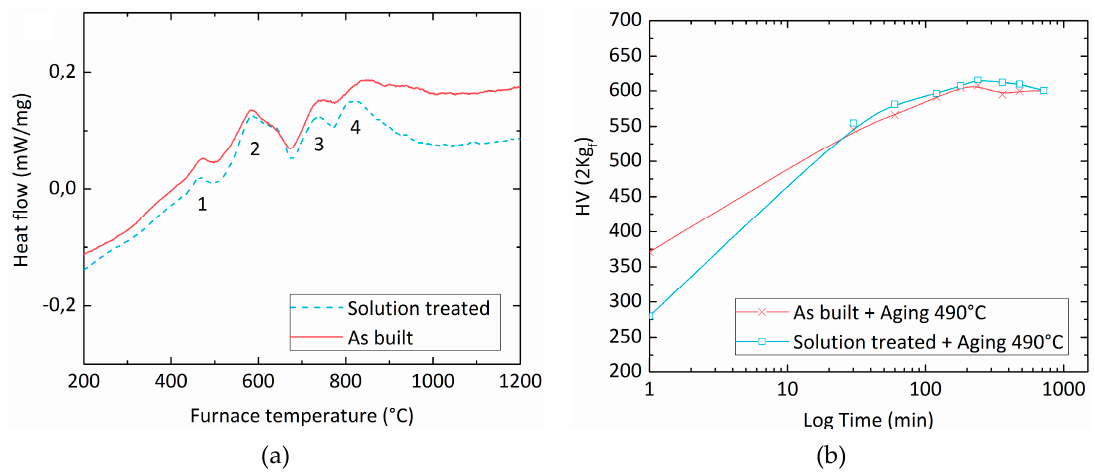
Figure 6. DSC scans at a heating rate of 20 °C/min comparing the aging behaviour of as ‐ built and solution ‐ treated samples ( a ). Hardness evolution of the two corresponding samples during isothermal holding at 490 °C ( b ).